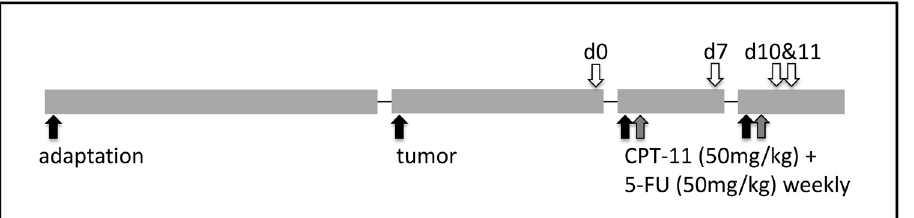
Figure 2. Experimental design. Black arrows represent diet, tumor, and CPT-11 treatments; grey arrows represent treatment with 5FU. Sampling at day 10 and 11 after the first CPT-11 treatment is indicated by white arrows.